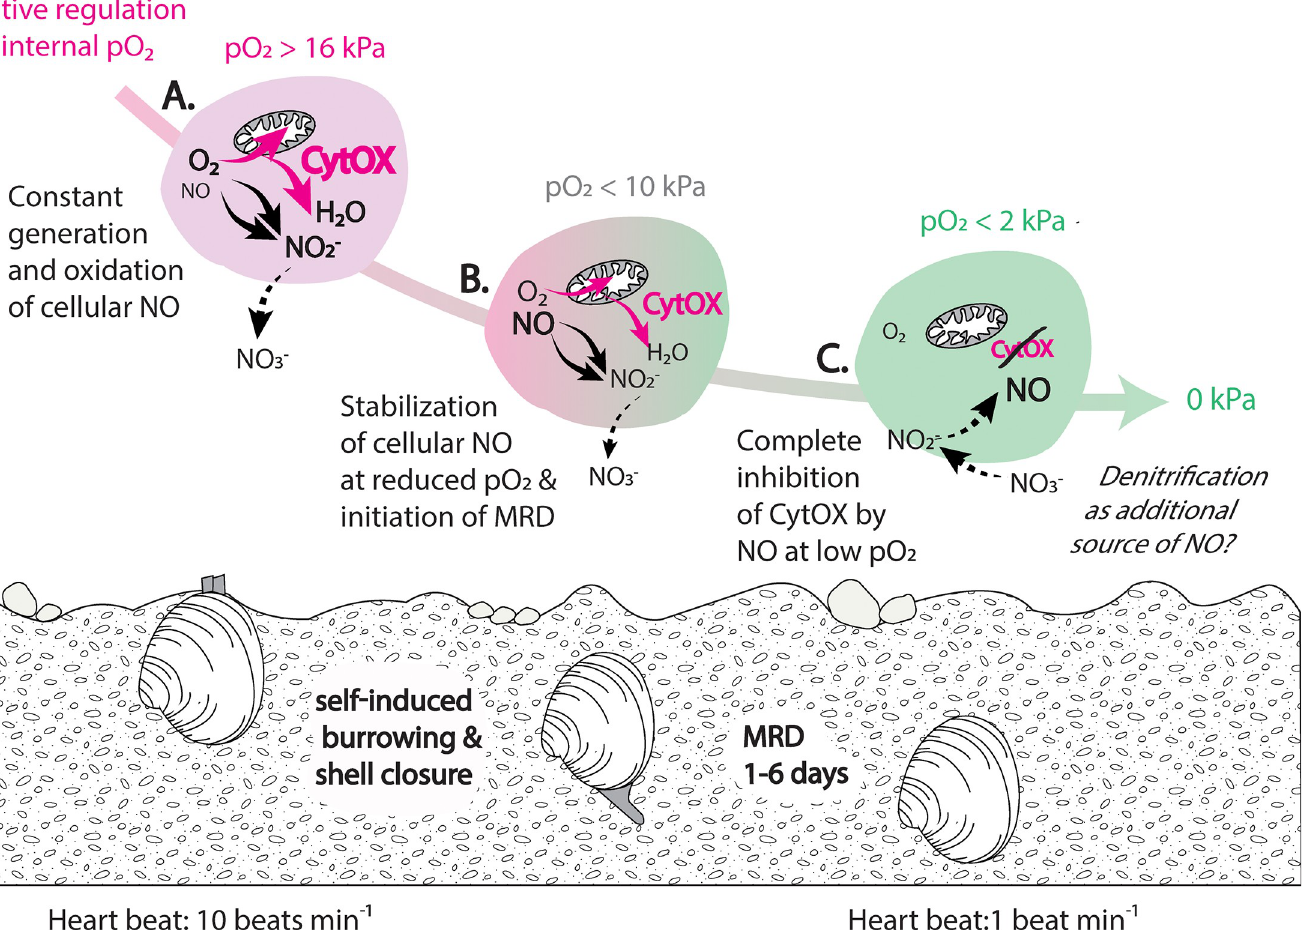
Fig 7. Potential role of nitric oxide (NO) in the mediation of metabolic rate depression (MRD) in Arctica islandica during self-induced burrowing and shell closure, when internal p O 2 is actively down-regulated. A. At p O 2 > 16kPa (pink background), standard metabolic rates are high (= high activity of cytochrome-c- oxidase, CytOX, fat pink arrows); cellular NO is constantly produced in the mitochondria and rapidly autoxidizes to nitrite (indicated by black arrows). B. During burrowing and shell closure, internal p O 2 is down-regulated to < 10kPa and cellular NO starts to stabilize (pink/green background); NO induces a metabolic rate depression (MRD) by reversible inhibition of mitochondrial CytOx (small pink arrows). C. At p O 2 < 2kPa (green background), NO reaches high stability and completely inhibits CytOx activity (CytOx crossed out); Hypothesis : NO might form by acidic reduction of nitrite , originating from nitrate reduction by facultative anaerobic bacteria associated with tissues of A . islandica (dashed arrows and italic type) , which may lower the amount of ROS produced during anoxia/hypoxia- reoxygenation events at the cellular level .